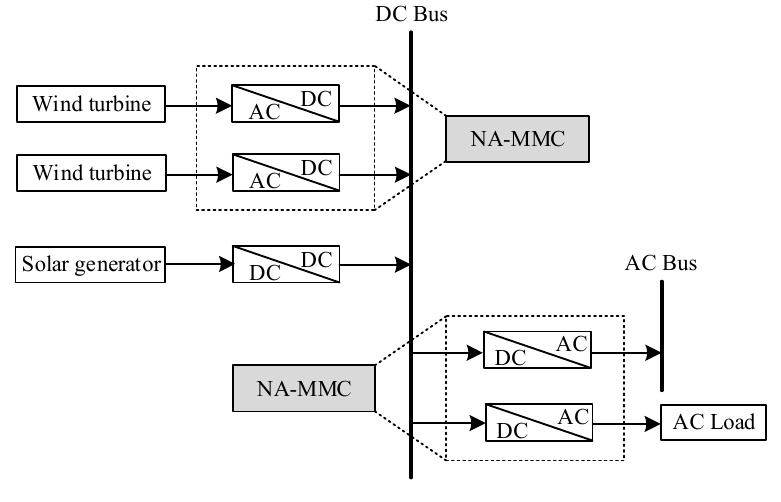
Figure 1 . NA-MMC application. Figure 1. NA-MMC